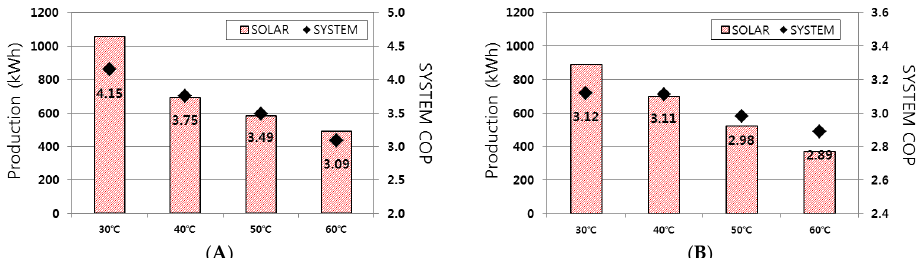
Figure 8. Solar heat production and COP according to the control temperature in SYSTEM 3. ( A ) Day;